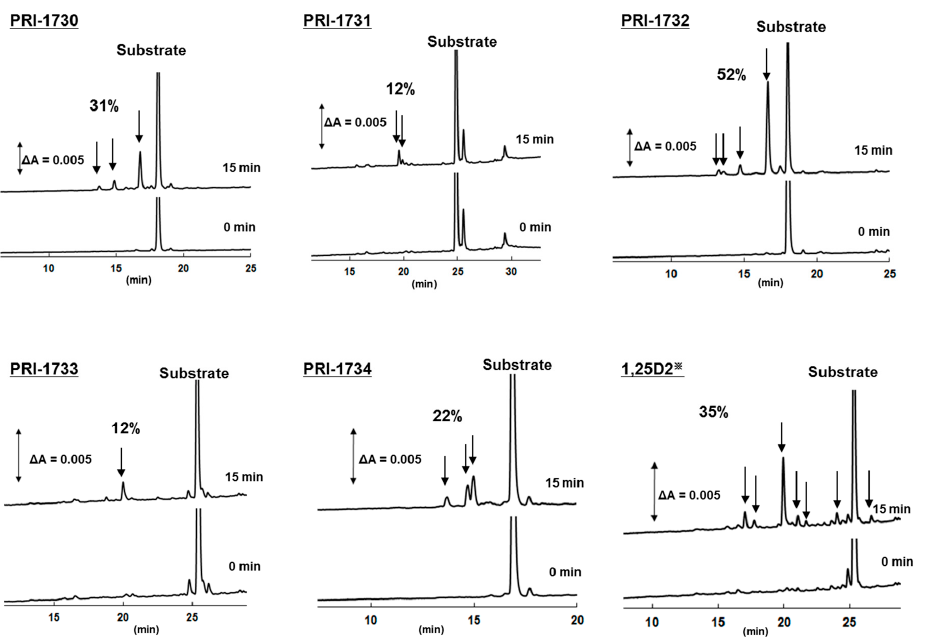
Figure 6. HPLC profiles of 1,25D 2 and of its analogues and their metabolites by human CYP24A1. The peaks with arrows indicate putative metabolites. The HPLC profile of 1,25D 3 is shown in Figure S1 in supplementary information of this paper. ※ The metabolic profile of native 1,25D 2 by human CYP24A1 was nearly the same as in our previous reports [15,16]. ∆ A indicates the absorbance difference at 265 nm.